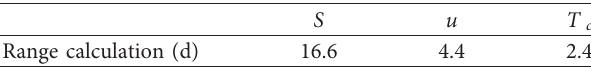
Figure 7: Curves of the effect of various factors on t e . (a) Distance between frozen pipes S vs. t e . (b) Seepage velocity u vs. t e . (c) Refrigerant temperature T c vs. t e . Table 3: Calculation of variance of t e